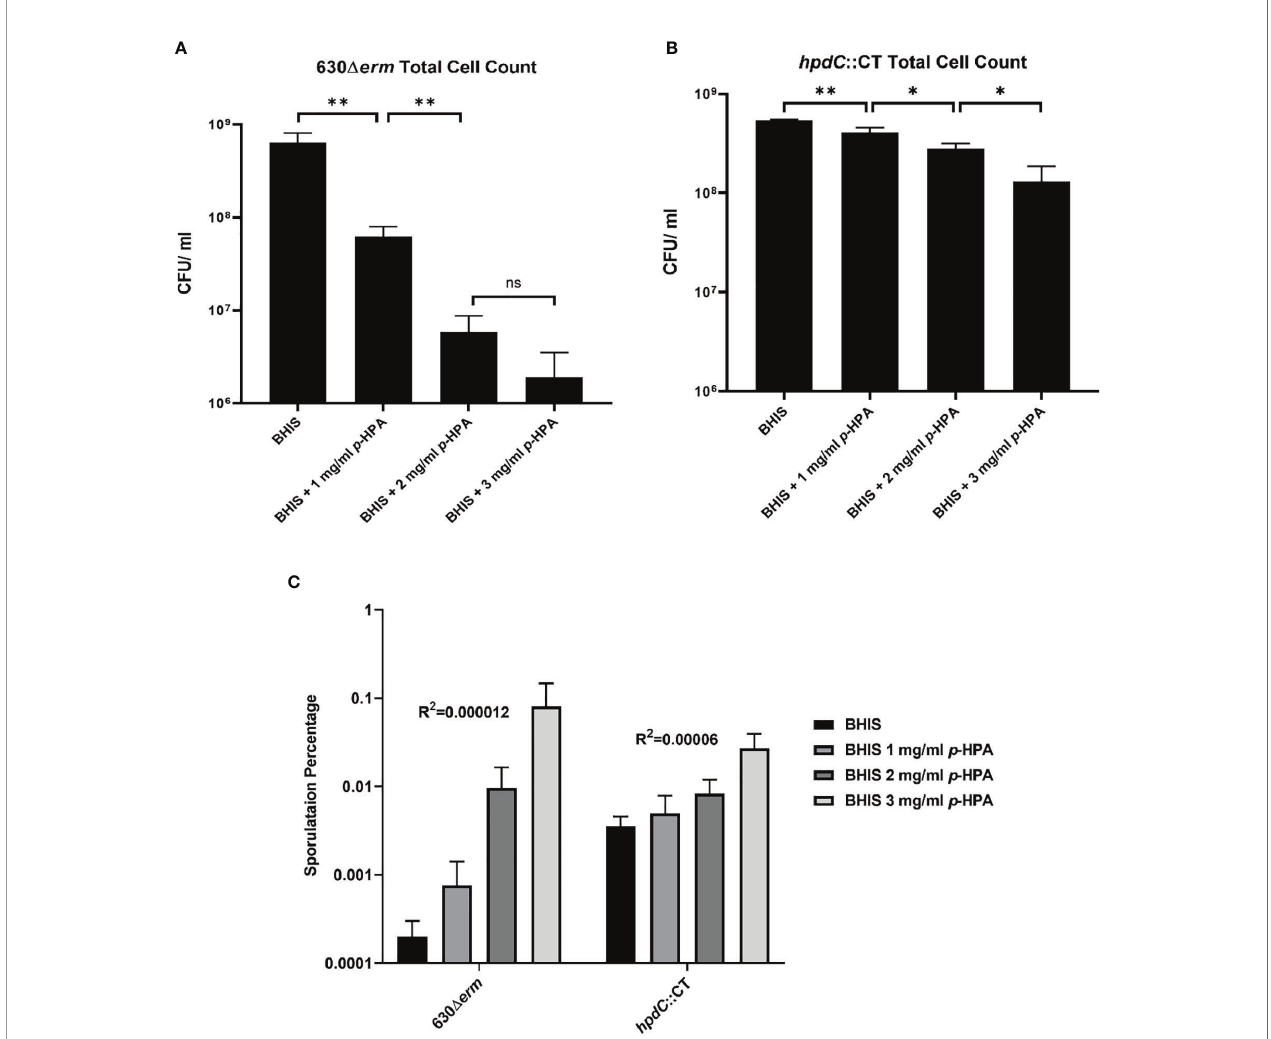
FIGURE 5 | Effect of p -HPA and p -cresol on sporulation rate and total cell count. (A) 630 D erm and (B) hpdC ::CT were grown for 24 h in BHIS in the presence of 0, 1, 2, or 3 mg/ml p -HPA. Colony forming units (cfu) were performed per ml of culture for total cell counts and spore count (spores obtained by heating the culture at 65°C for 20 min) by plating on to BHIS plates containing 0.1% sodium taurocholate. (C) Percentage sporulation in 630 D erm and hpdC ::CT mutant in BHIS media alone, or media supplemented with 1, 2 or 3 mg/ml p-HPA. Statistical analysis for a correlation between p -HPA concentration and sporulation rate was carried out by Spearman one-tailed rank – order correlation. Statistical analysis to determine differences in total cell count was carried out by regression. Data represents the minimum of three independent replicates, error bars represent standard deviation, and signi fi cant differences are indicated: * p < 0.05, ** p < 0.01, ns, non signi fi